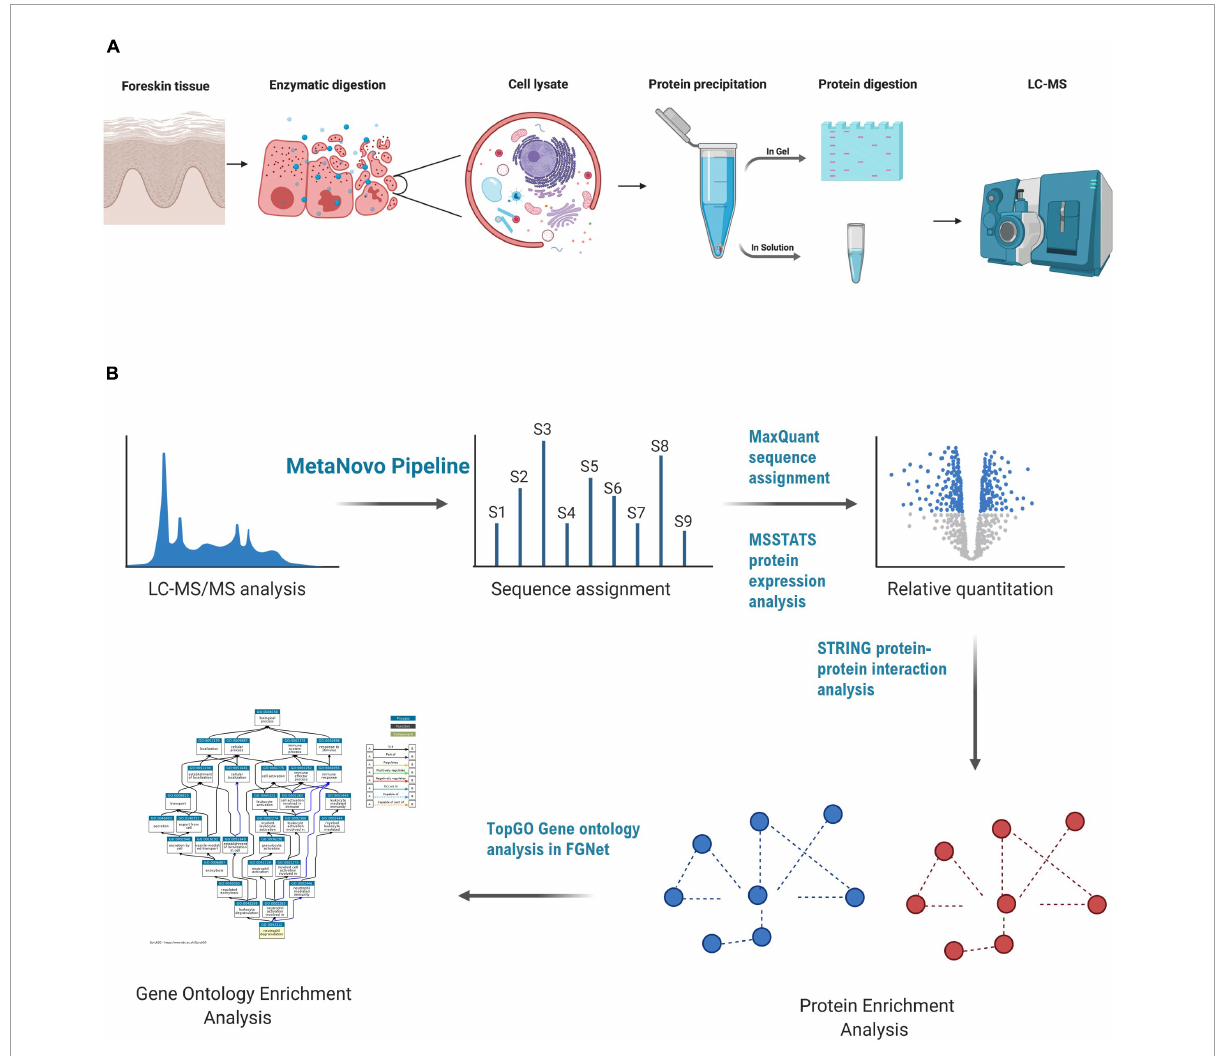
FIGURE1 LC-MS-based proteomics of foreskin samples and data analysis methods used to assess the impact of aSTI on the foreskin proteome. (A) Equal mass of inner and outer foreskin samples were dissected, and proteins were solubilized and digested with trypsin enzyme to create peptides that were analyzed by LC-MS. In-gel digestion method, FASP, and in-solution digestion methods were performed to determine the appropriate method for foreskin peptide generation. (B) Data analysis method after the acquisition of peptide mass spectra composed of database optimization using the MetaNovo pipeline which was used to optimize sequence assignment. Subsequent label-free quantification of identified protein groups was performed using MaxQuant, and differential protein expression was analyzed using the MSSTATS protein analysis pipeline for relative quantification of proteins from aSTI foreskins compared to age-matched controls. GO enrichment analysis of differentially expressed proteins was conducted in FGNet using the TopGO function. This figure was generated using